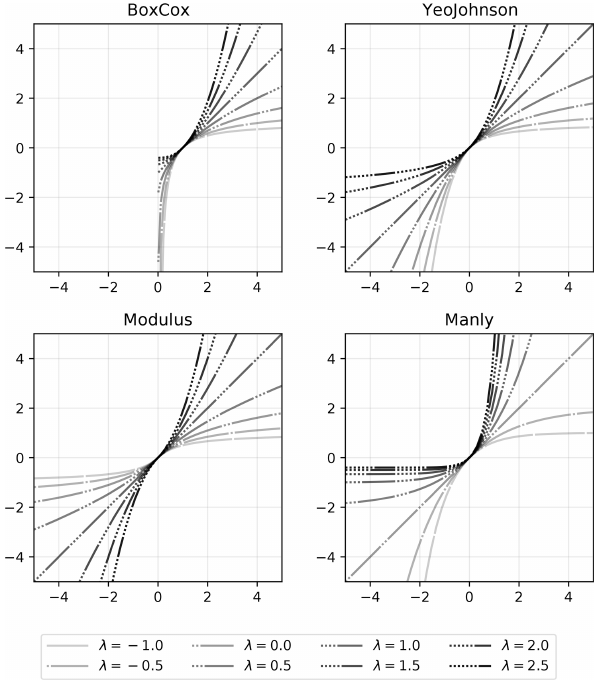
Figure 8. Comparison of parametric normalizers in GSTools